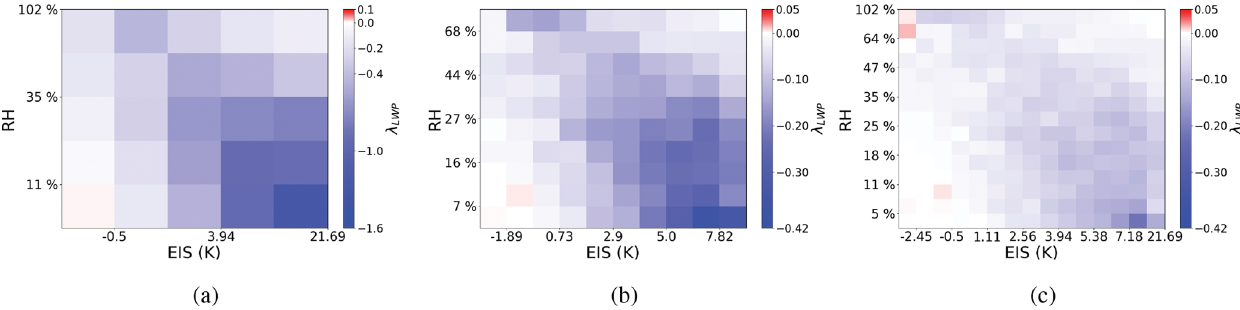
Figure 7. The sensitivities of CRE to aerosol from Eq.( 9) within environmental regime resolutions of (a) 5 by 5 ( − 10 . 8Wm − 2 ln(AI) − 1 ), (b) 10 by 10 ( − 10 . 6Wm − 2 ln(AI) − 1 ), and (c) 15 by 15 ( − 10 . 6Wm − 2 ln(AI) − 1 ) summed over all cloud states. Unlike all previous sensitivity estimates, these are weighted by occurrence.